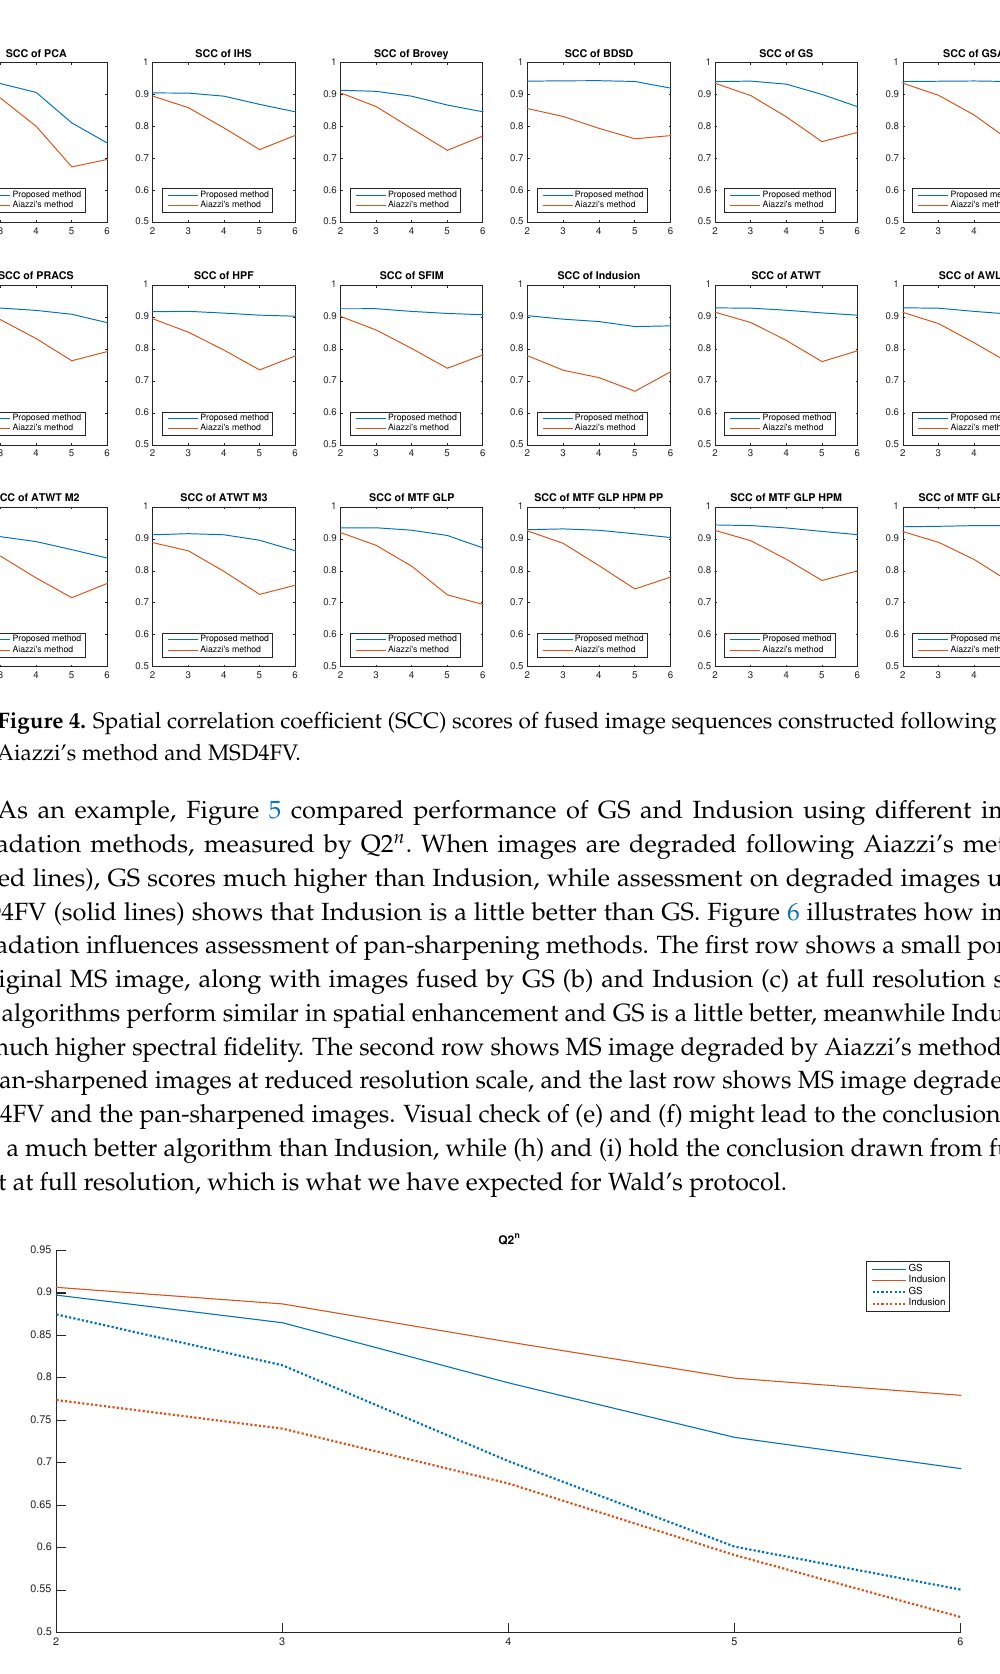
Figure 5. Q2 n scores of fused image sequences constructed following Aiazzi’s method (dotted line) and MSD4FV(solid